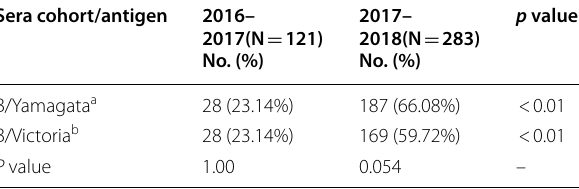
Table 2 Comparing prevalence of HI titers to B/V and